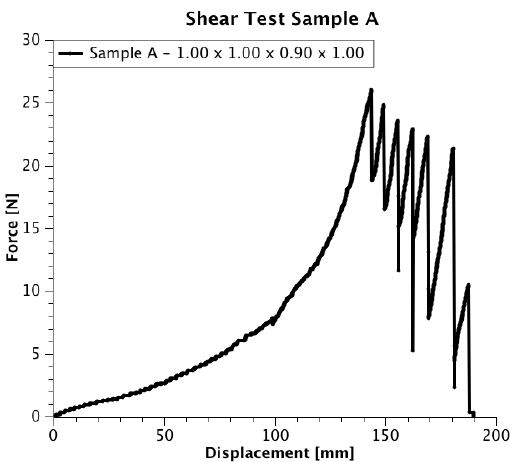
Figure 7. Raw-data of sample A; force F is plotted over displacement x .